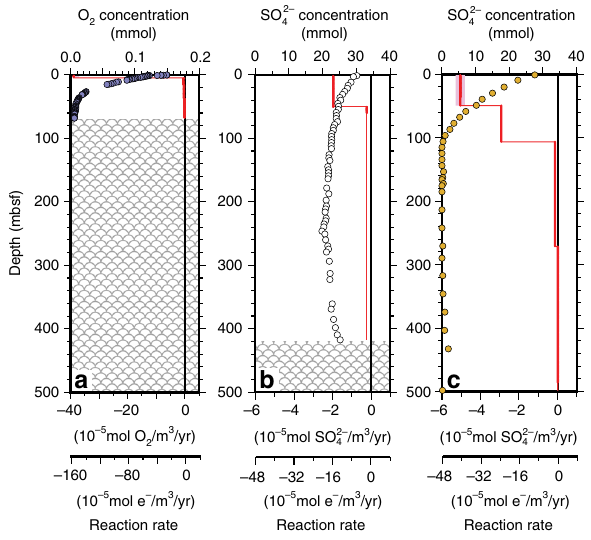
Fig. 2 Pro fi les of net respiration rates at representative sites. a Pro fi le of net respiration rate (O 2 reduction rate) as a function of sediment depth at oxic IODP Site U1370 (dark blue zone in Fig. 1). b Pro fi le of net respiration rate (SO 4 2 − reduction rate) as a function of sediment depth at anoxic ODP Site 1226, where dissolved SO 4 2 − is present throughout the sediment column (white zone in Fig. 1). c Pro fi le of net respiration rate (SO 4 2 − reduction rate) as a function of sediment depth at anoxic ODP Site 984, where dissolved SO 4 2 − is depleted at a relatively shallow sediment depth (yellow zone in Fig. 1). Circles mark chemical concentration data color-coded to the Fig. 1 geographic zones in which the sites occur (dark blue, white and yellow, respectively). Red lines mark net respiration rates and pink bars mark uncertainty ( fi rst standard deviation). Crosshatched zones in A and B Fig. 3 Pro